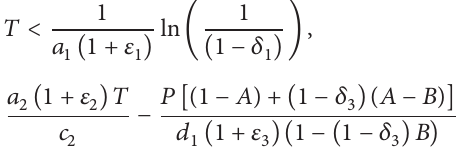
Theorem 14. The periodic solution (0, 0, 𝑧 ∗ (𝑡)) of system (3) with mixed Holling type III-IV functional responses is